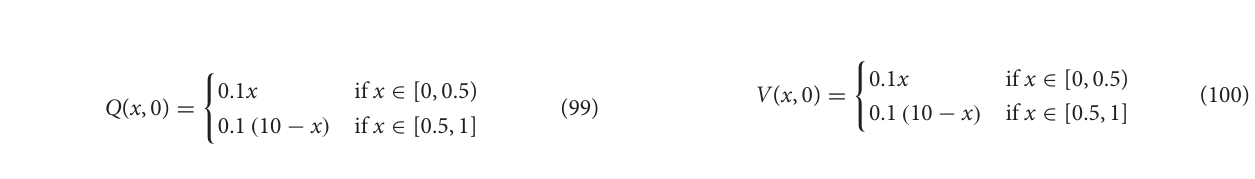
0.1 x if x ∈ [0, Q ( x , 0) = (